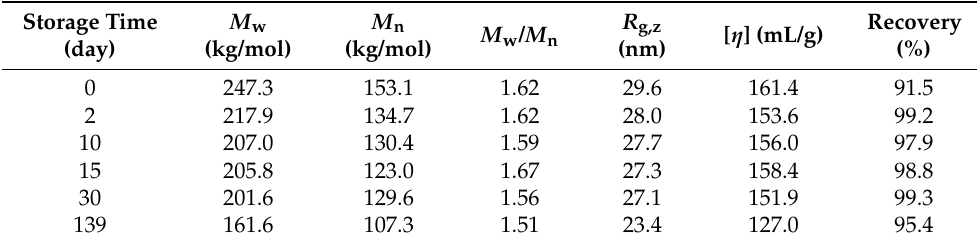
Figure 4. ( a ) RI and ( b ) LS at 90° signals as a function of elution volume, ( c ) molecular weight distribution curves, and ( d ) variation of M w and M n with storage time for PAA stored at 4 °C. The label 4 °C-0 d represents the original PAA solution, while 4 °C-2 d represents that it was stored at 4 °C for 2 days. Table 4. Molecular parameters of (6FDA-DMB) PAA in a concentrated solution stored at 4 °C for different times, measured by GPC-RI-MALLS-VIS.